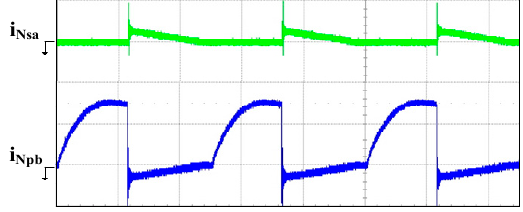
Figure 20. Experiment of current waveforms (i Nsa, i Npb ), i Nsa, i Npb : 500 mA/div, Time: 20 µs/div.